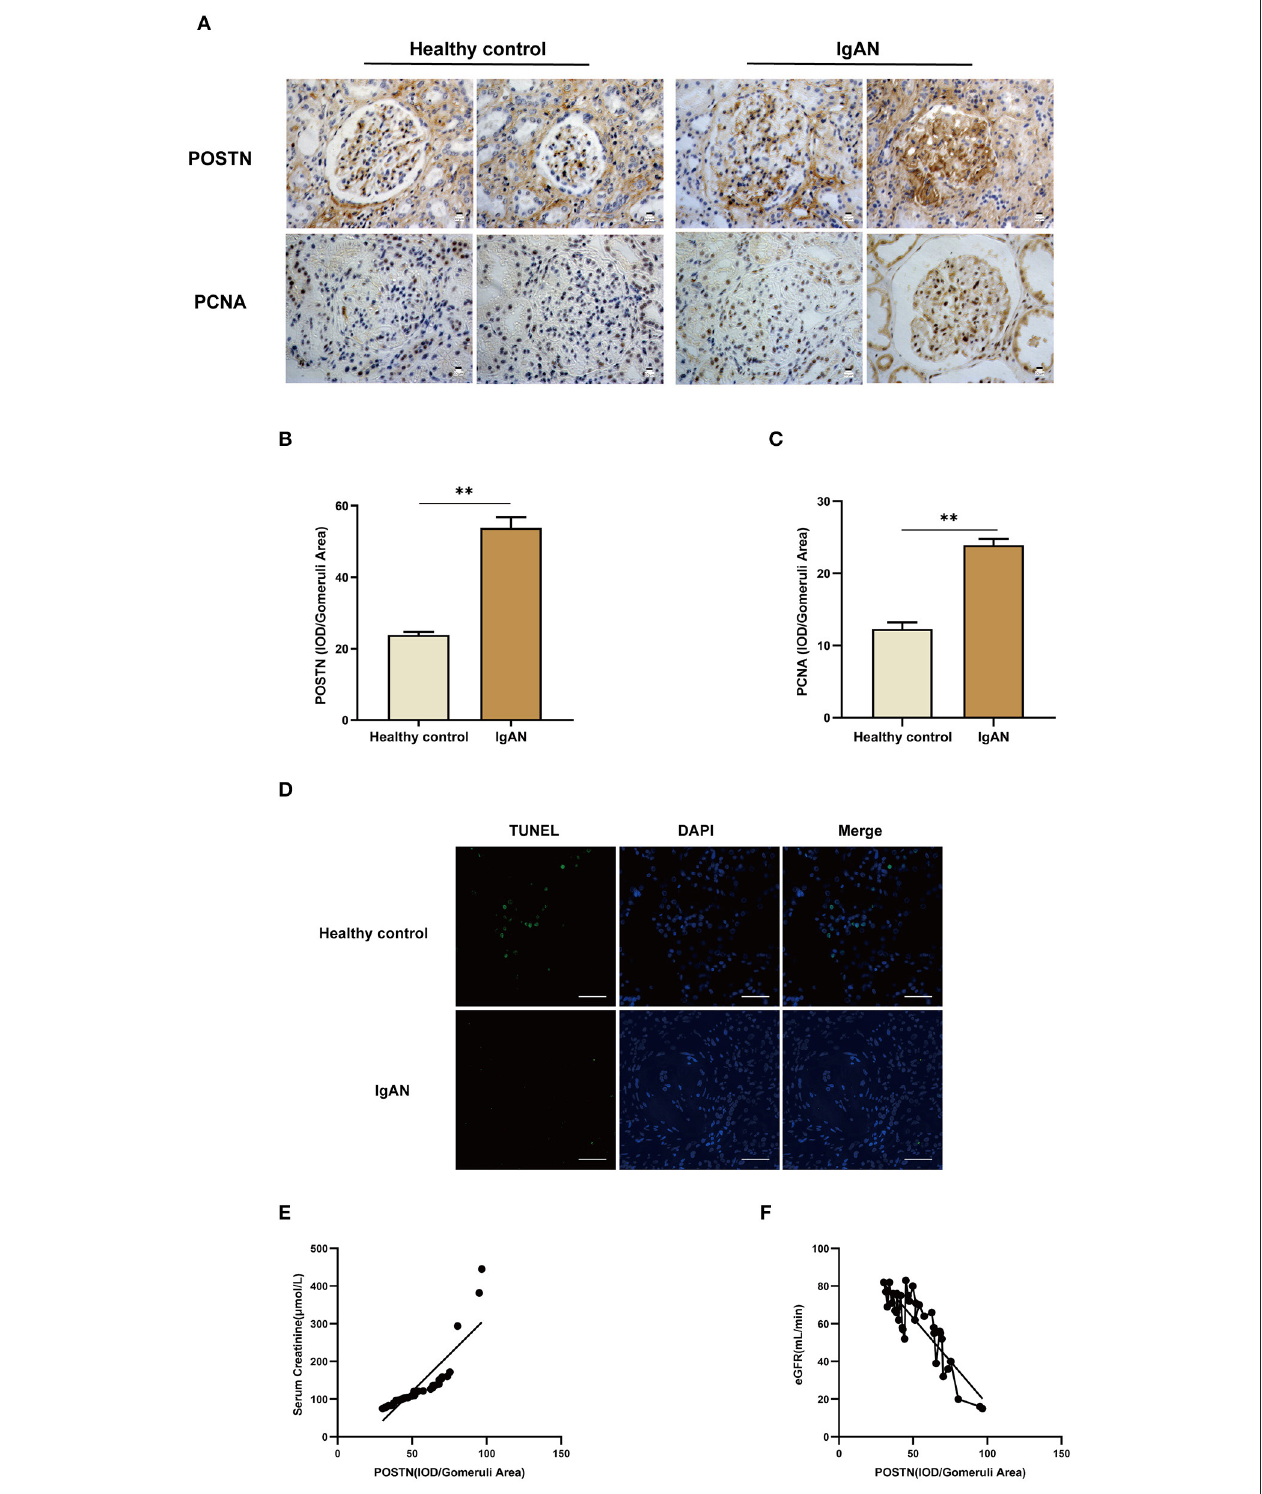
FIGURE 8 | POSTN is highly expressed in the kidney of IgAN patients and is closely related to renal dysfunction. (A–C) IHC and quantification of POSTN and PCNA in human renal tissue. (D) TUNEL staining of renal tissue samples from IgAN patients and healthy controls. Scale bar: 50 µ m. (E,F) Pearson correlation analysis of the correlation between POSTN and creatinine/eGFR. Data are presented as mean ± SEM (IgAN patients, n = 35 and healthy controls, n = 15). ** P < 0.01.